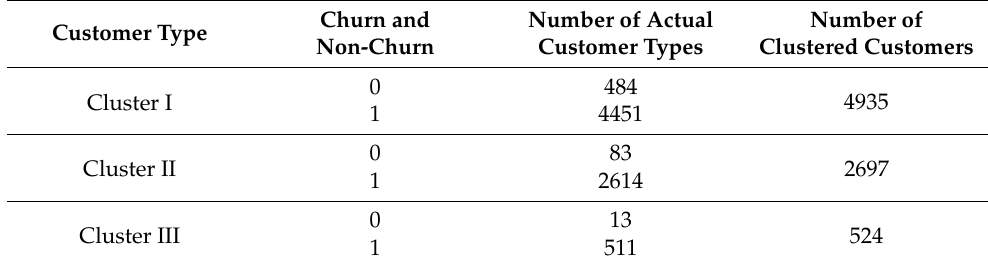
Table 1. Results of K-means classification.